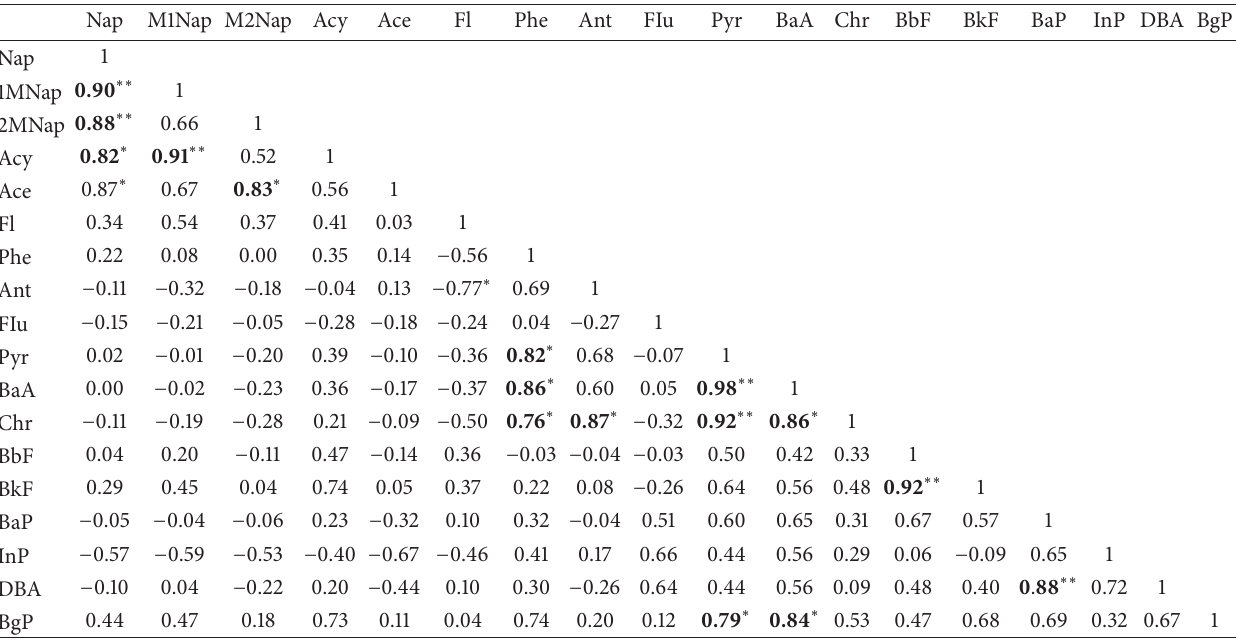
Table 4: Correlation coefficient between individual PAH